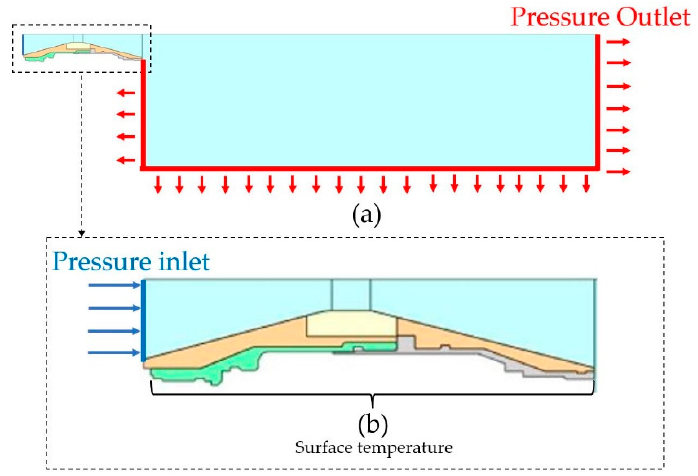
Figure 9. The boundary conditions settings for ( a ) an overview and ( b ) an enlarged picture in the nozzle. Blue is for the pressure inlet, while red is for the pressure outlet.